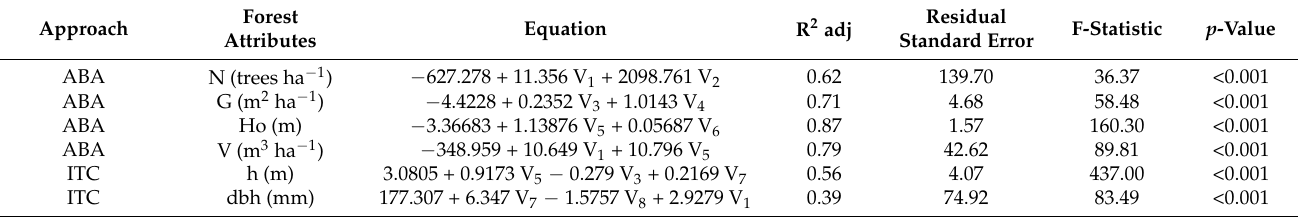
Table 2. Adjusted multivariate linear equations for the forest attributes of Pinus radiata stands in Ñuble Region (South, Chile) using the Area-Based Approach (ABA) and Individual Tree Crown (ITC) approach. Adjusted models with their predictor variables, adjusted coefficient of determination, residual standard error, F-statistic, and p-value are shown. Density (N), basal area (G), Assman ´ s dominant height (Ho), and commercial volume of up to 8 cm minimum diameter (V).